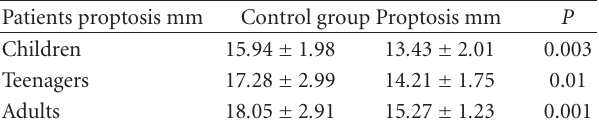
Table 3: Proptosis in children, teenagers, and adults with Graves’